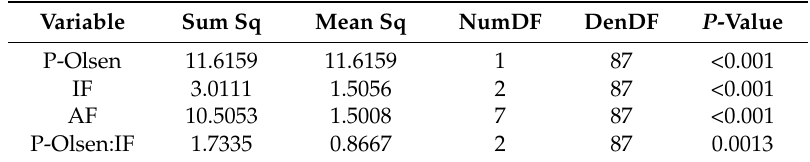
Table 4. Analysis of Variance with Satterthwaite’s method. P-Olsen: IF denotes the interaction between P-Olsen and IF.